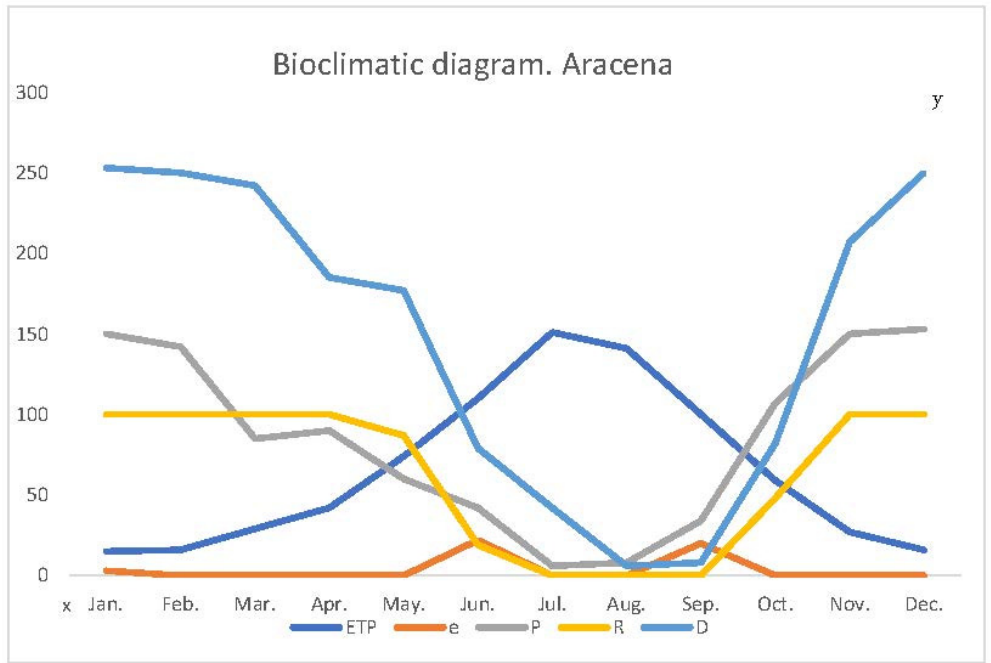
Figure 5. Bioclimatic diagram for Aracena: P = precipitation, ETP = potential evapotranspiration, D = water availability, R = soil water reserve, e = residual evapotranspiration (mm. water); Y: mm. Water; X: Month.